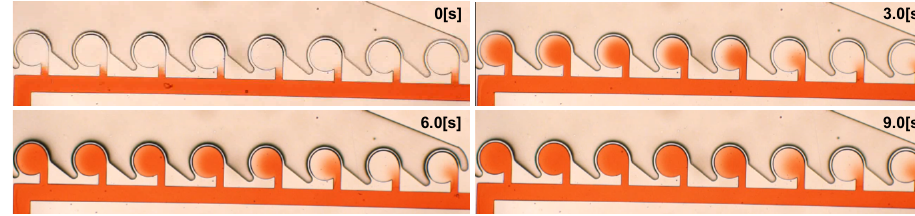
Figure 10. Time variation of experiment using colored water.